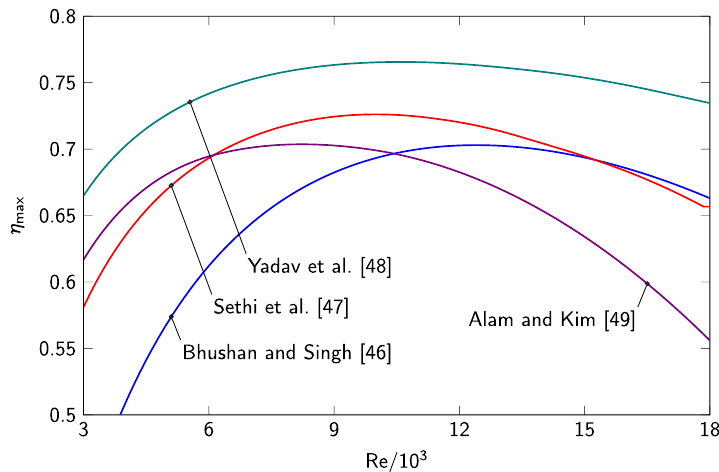
Figure 14. Relationship between η max and Re for absorber plates with round obstacles and ˙ G = 500Wm − 2